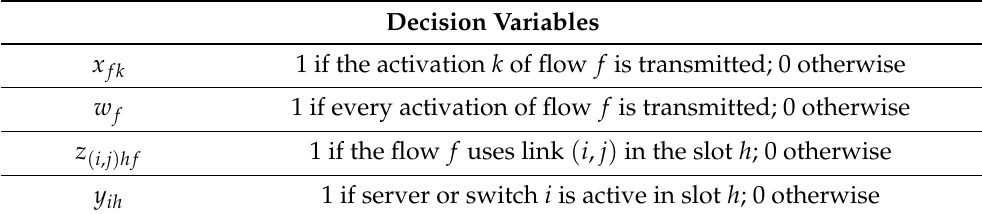
Table 2. Variables of the ILP model.